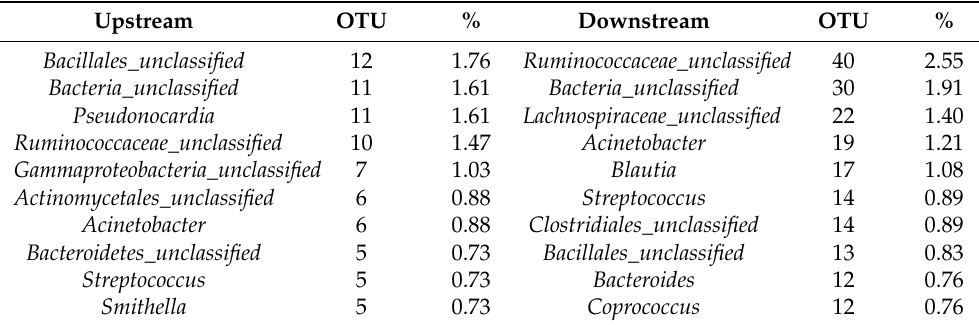
Table 1. Comparison of the 10 most abundant taxa in the air from the biofilter affluent (upstream) and effluent